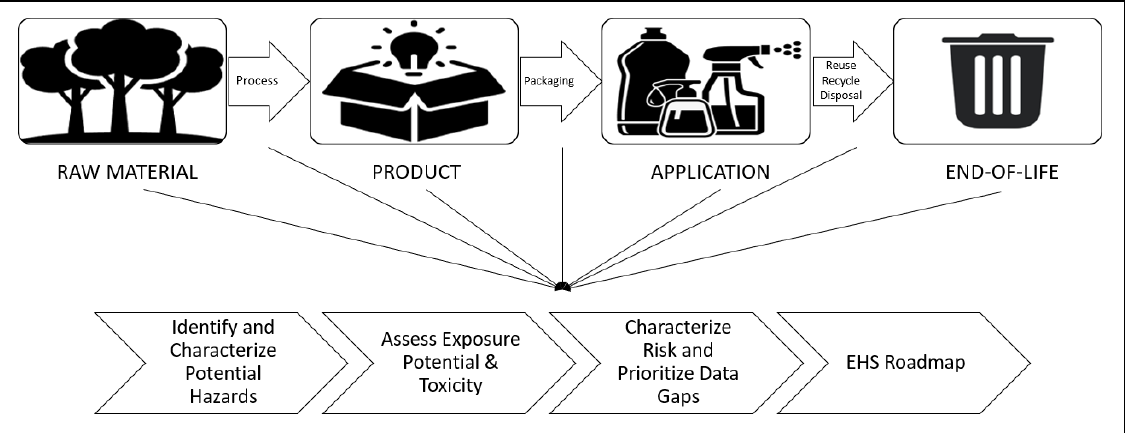
Figure 9. NANO LCRA flowchart of the complexity of risk assessment of a nanomaterial throughout its life cycle. Adapted from [151].